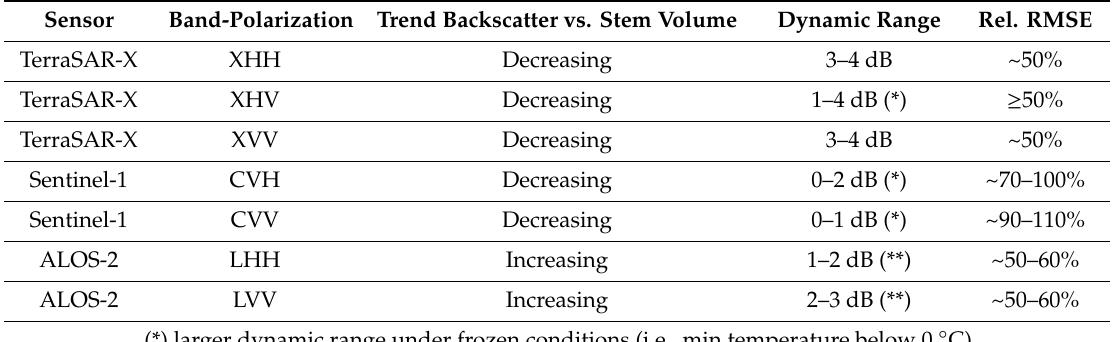
Table 4. Multi-temporal characteristics of the relationship between SAR backscatter and stem volume at Remningstorp for a given frequency band and